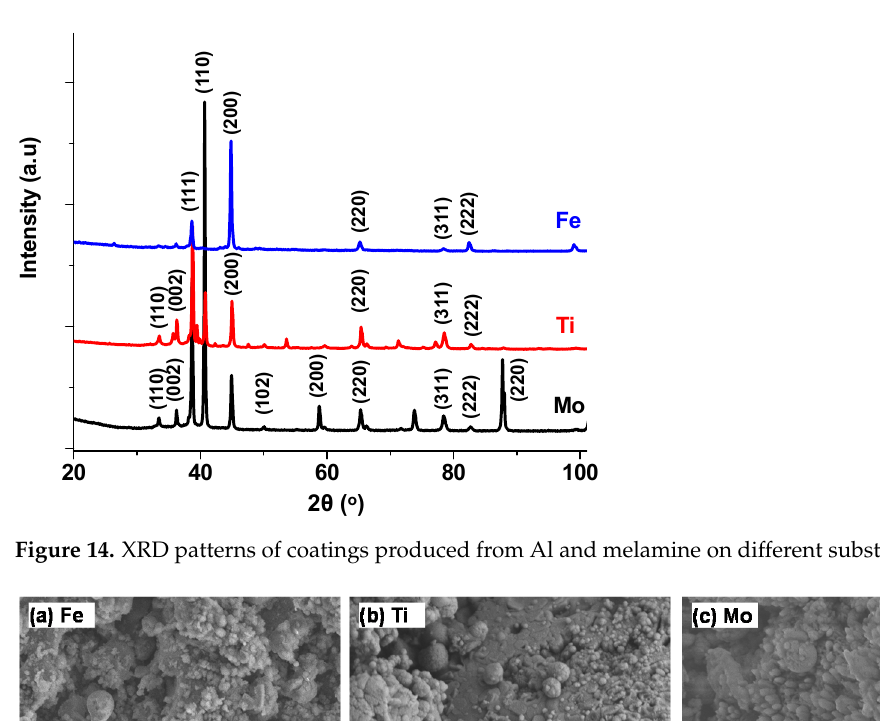
Figure 15. SEM images of coatings produced from Al powder and melamine on different substrates: ( a ) carbon steel, ( b ) Ti and ( c ) Mo, in ×20,000 magnification.